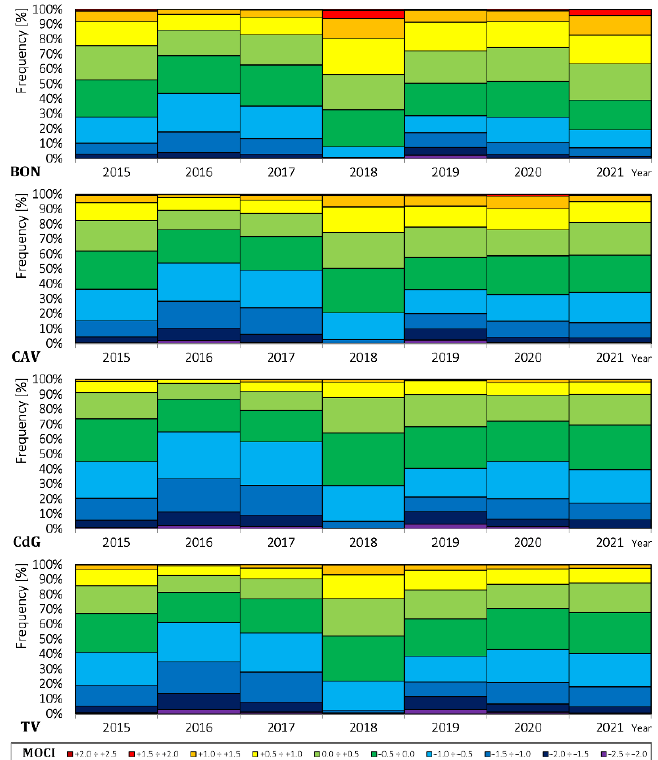
Figure 4. MOCI frequencies for the four ARPA stations. The frequencies are calculated using diurnal (from 06:00 to 19:00 LT) hourly data and are presented in yearly units.